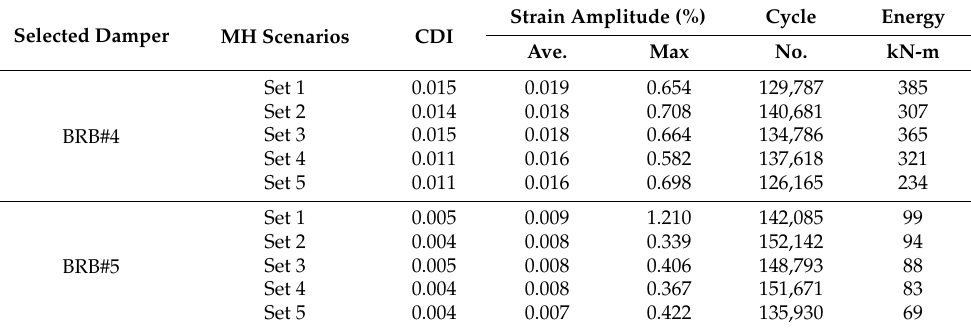
Figure 17. Cumulative damage index (CDI) of selected BRBs under multi-hazard scenarios.